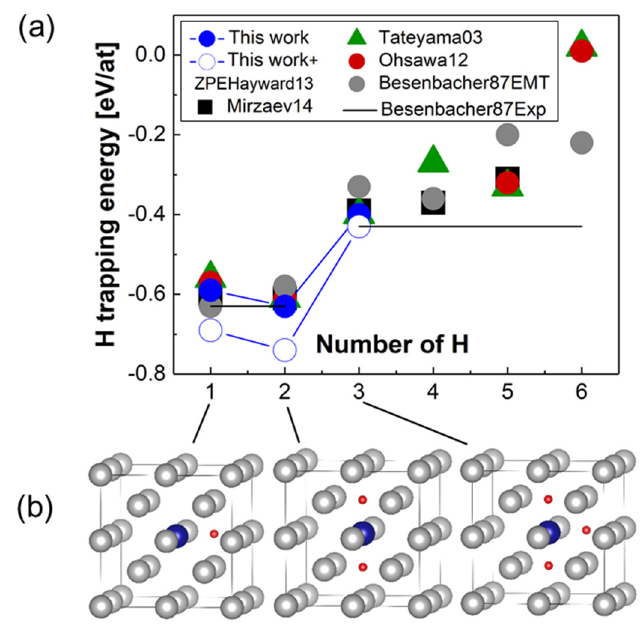
Figure 6. ( a ) Dependence of the H-trapping energy on the number of H atoms ( n ) in the n H-V cluster. The results of the present calculations are compared to other theoretical data [12,24,114] and experimental results [115,116]. ( b ) Structures of H-vacancy clusters are shown in the bottom panel. The vacancy is marked as a blue circle. Hydrogen atoms are shown with small red circles.